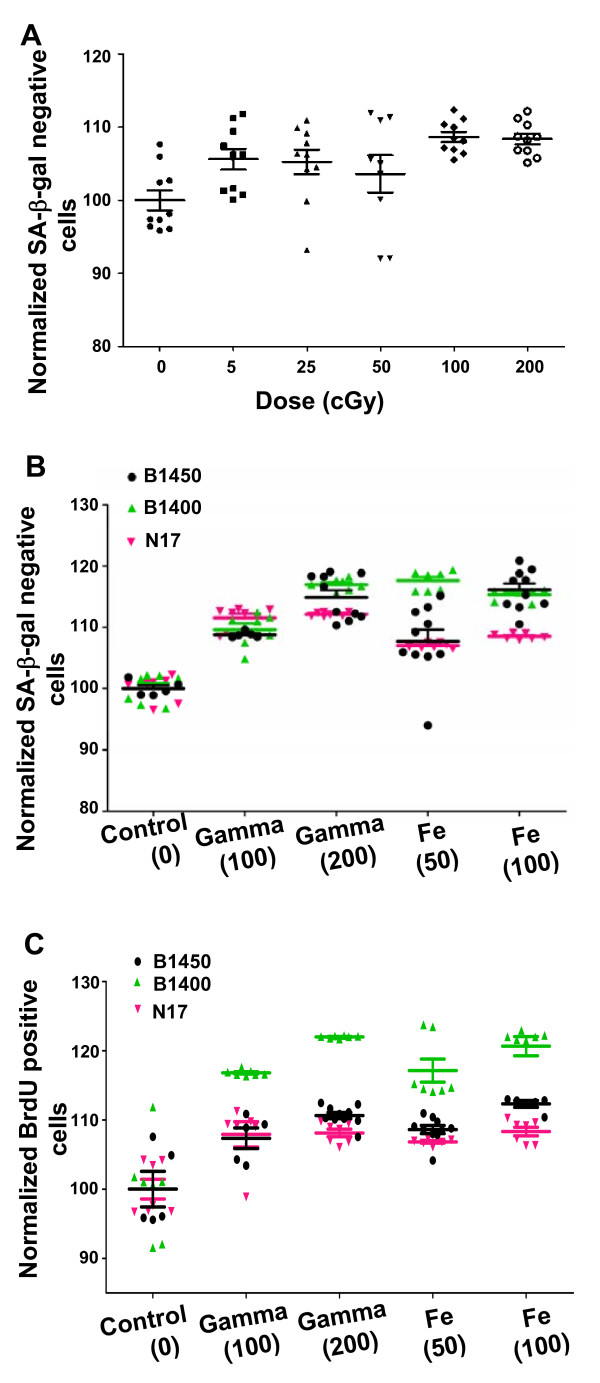
Radiation of different doses and qualities promotes outgrowth of variant human mammary epithelial cells. (A) Human mammary epithelial cells (HMEC) cultures (10 or more replicates per dose) from specimen B1450 were subjected to X-ray doses between 5 and 200 cGy. Each treatment group was normalized to a control group and the resulting means ± SE were plotted versus dose. (B and C) When assayed four to six weeks after irradiation with indicated doses (cGy) of 56Fe or γ-rays, indicated HMEC cultures showed statistically significant differences (P < 0.0001, non-parametric Wilcoxon test) in the percentages of (B) SA-βgal (-) and (C) BrdU (+) cells compared to control cultures. Scatter plots indicate the mean ± SE of between 5 and 10 independent replicates for three individual specimens assayed for each treatment.